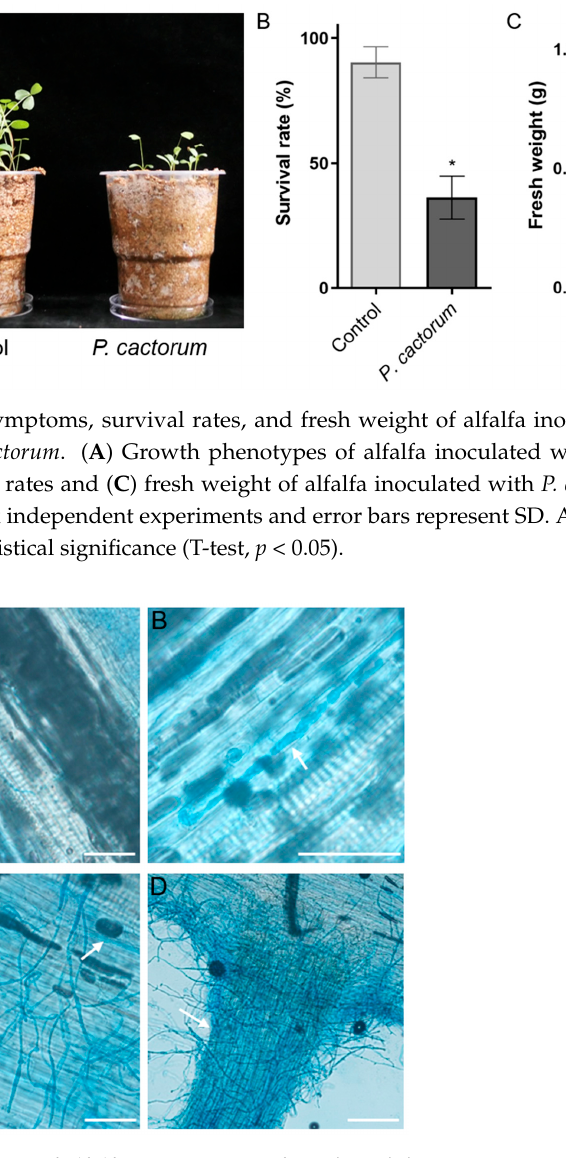
Figure 4. Photo of alfalfa root staining after Phytophthora cactorum infection. ( A , B ) Invasive hypha grows intercellularly in epidermal cells. Different root tissues were stained with the lactophenol- trypan blue for 30 s before microscope observation. Infectious growth was observed at 24 hpi. ( C ) Invasive hypha grows in/outside of alfalfa cells. Infectious growth was observed at 36 hpi. ( D ) Typ- ical infection sites of alfalfa roots inoculated with P. cactorum strain, showing stained mycelium wrapped around alfalfa roots and proliferation within tissue. Infectious growth was observed at 48 hpi. Scale bars = 100 μ m. The arrow indicates typical infection hypha.